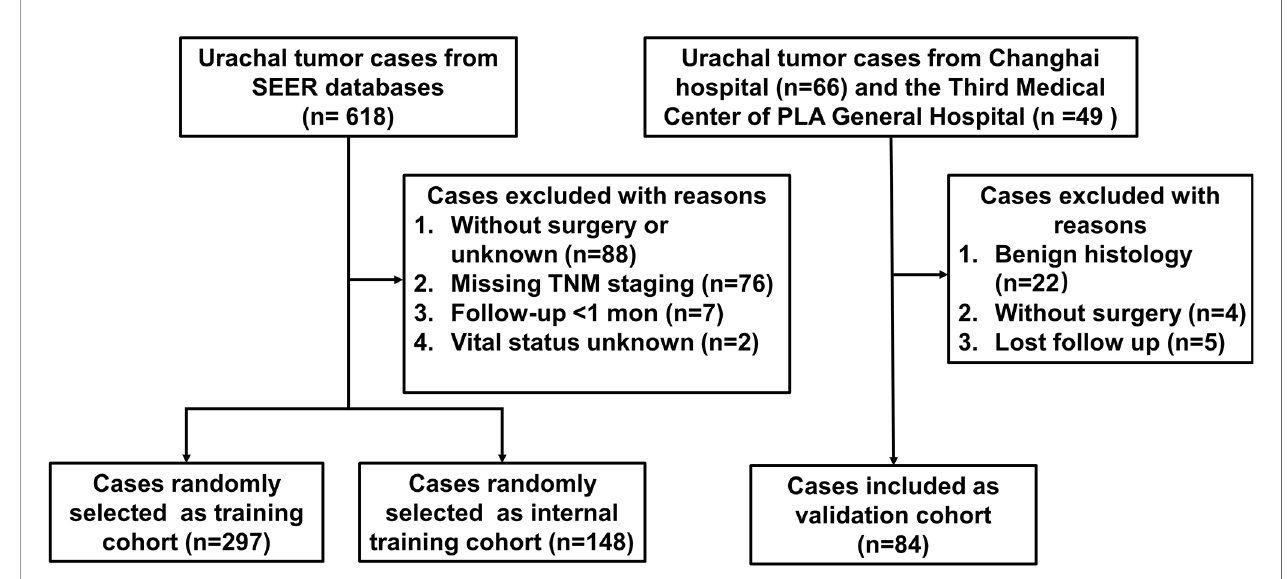
FIGURE 1 | Flowchart illustrating patient selection for this